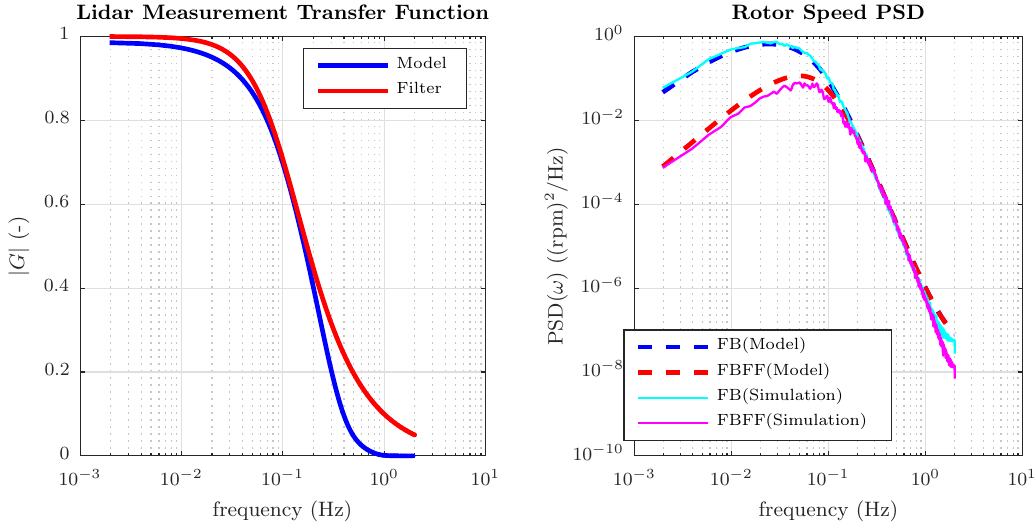
Figure 9. ( Left ) Transfer function from frequency domain model and fitted filter using optimal circularly-scanning CW lidar scan. ( Right ) Power spectral density of rotor speed for feedback-only (FB) and combined feedback-feedforward (FBFF) control from frequency domain model as well as simulations using optimal lidar